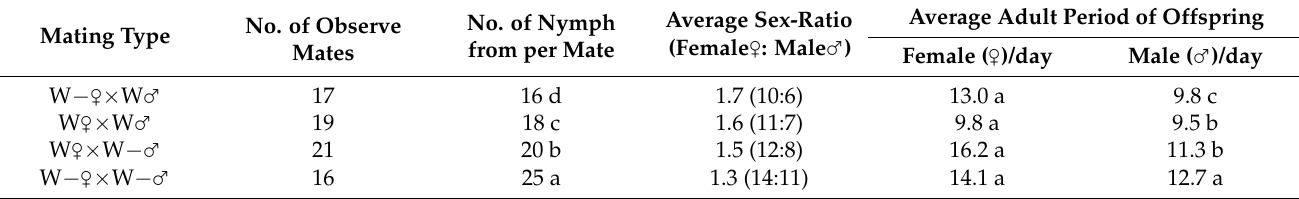
Table 1. Influence of mating types on the offspring number, sex ratio and life span of the tea green